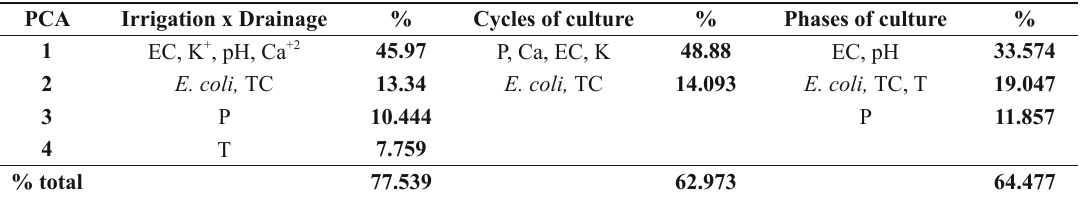
Partial and total variance explained by principal component analysis in Cachoeirinha/RS/Brazil. The variable has a correlation > 0.75 with the PCA.